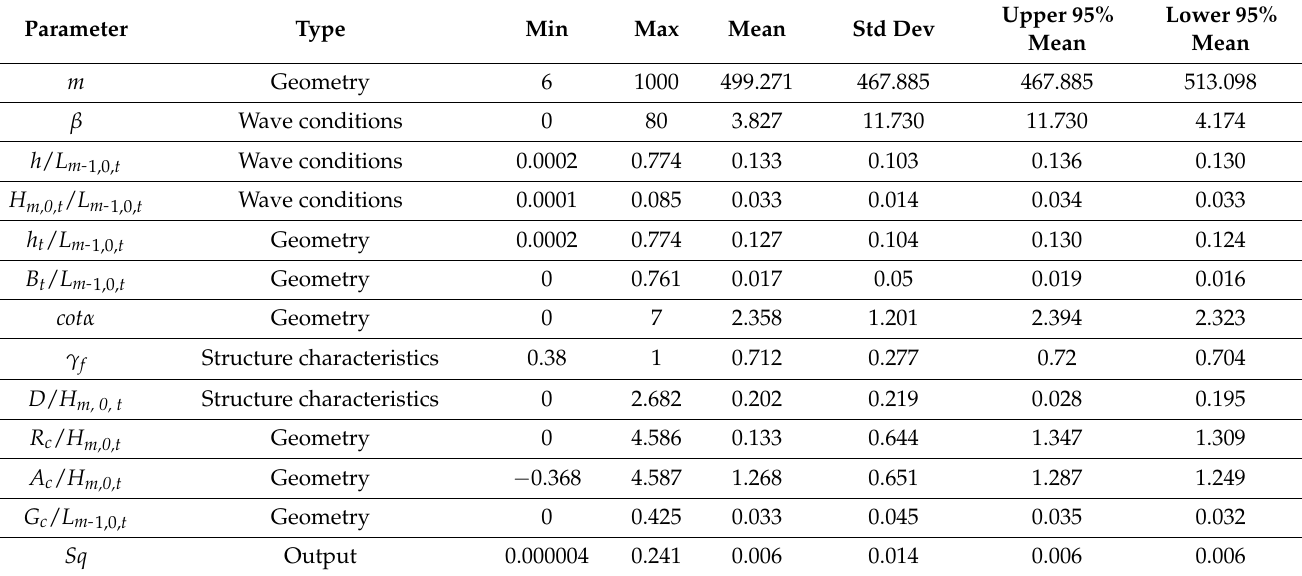
Table 3. Input and output parameters of the ANN and SVM